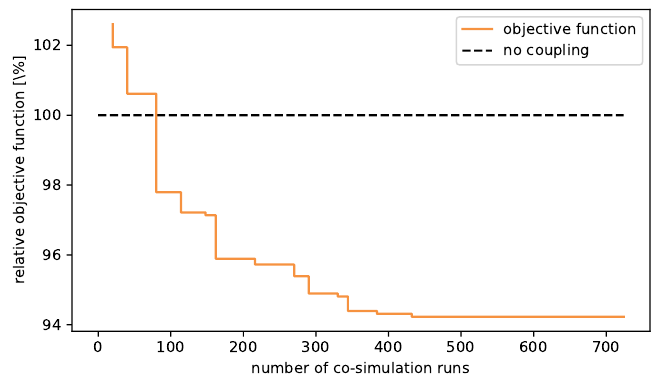
Figure 11. Convergence of objective function shown relative to the reference scenario without coupling between the networks, i.e., no electric boilers.